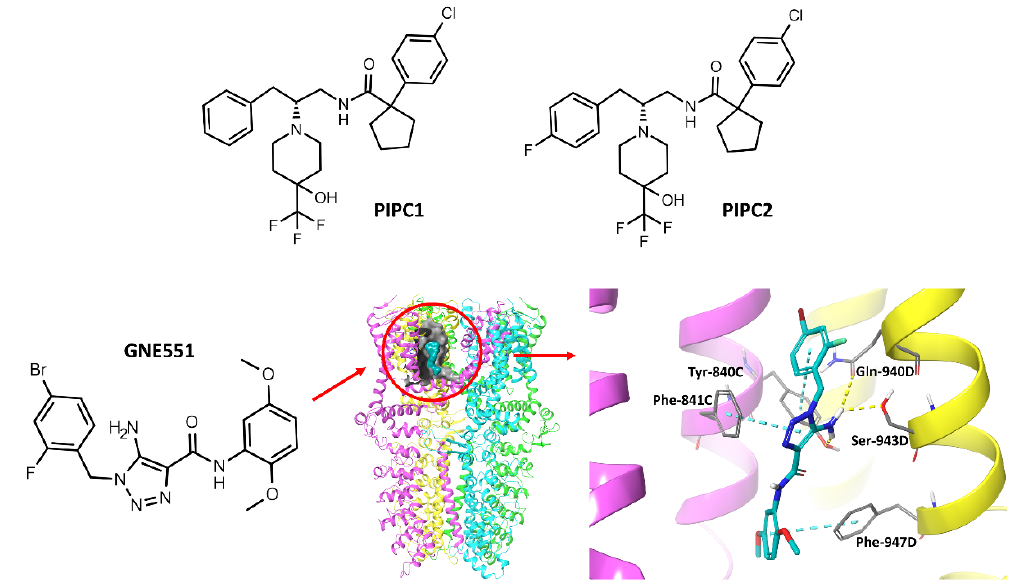
Figure 3. Structures of TRPA1 noncovalent agonists: PIPC1 and PIPC2 (piperidine carboxamide derivatives) and GNE551, showing its binding site location in the TRPA1 structure and its binding mode (yellow—hydrogen bonds, cyan— π - π stacking interactions) based on PDB: 6X2J [13].